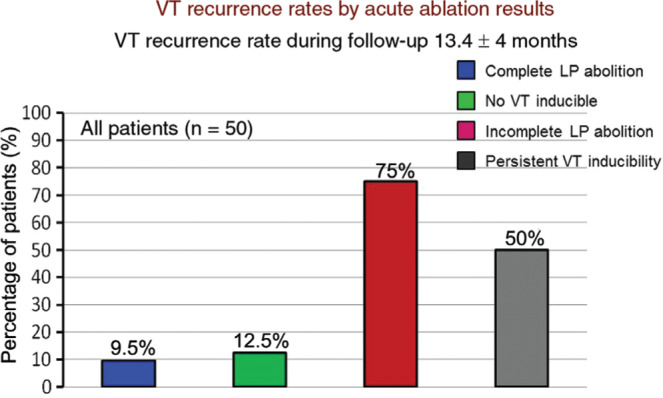
VT recurrence rate by acute ablation results. In patients with post-infarction VT, successful late potential abolition and post-procedural VT non-inducibility constitute significant endpoints after catheter ablation. Complete late potential abolition or elimination reduces VT recurrence to exceptionally low rates and compares favorably with post-procedural non-inducibility of VT. Persistence of late potentials/LAVAs or persistent inducibility predict a poor outcome. LAVAs: local abnormal ventricular activities; LP: late potential; VT: ventricular tachycardia.